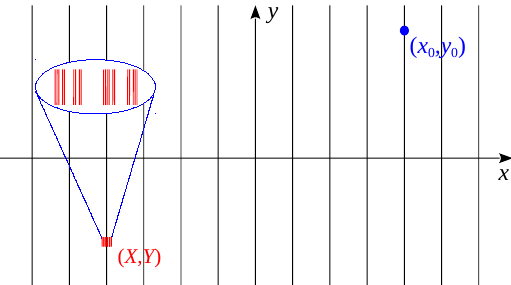
Figure 1. A random walk on a comb in the presence of a fractal sink structure. This fractal structure, where the sink points are placed at y = Y , is shown in zoom. The comb consists of the backbone- x axis and the y direction corresponds to continuously distributed fingers along the backbone. This structure results from the phenomenological consideration of 2D diffusion with diffusion coefficients D xx = D x δ ( y ) and D yy = D y , where D x , D y are constant values